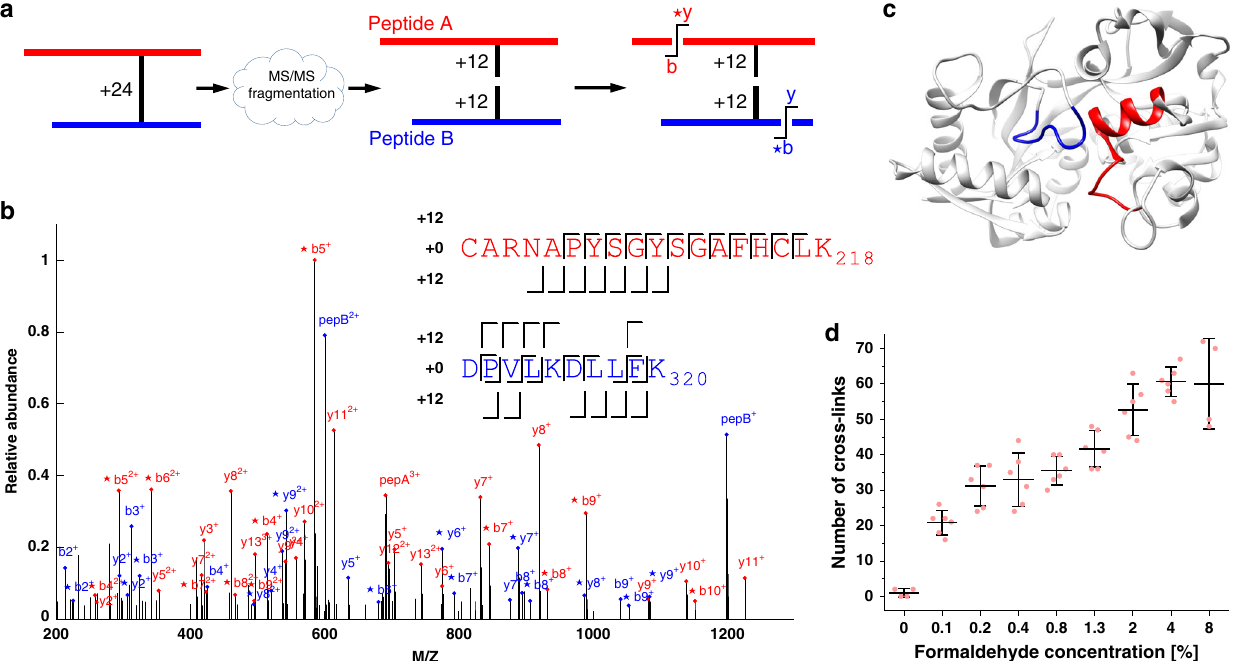
Fig. 3 Mass spectrometry characteristics of FA cross-links. a The MS/MS fragmentation of a formaldehyde cross-link breaks the ion to its two peptides, each with an additional mass of 12 Da. The two peptides then break a second time to produce b- and y-fragments. b The MS/MS spectrum of a cross-link between two peptides of ovotransferrin. pepA and pepB are peaks matching the total mass of the corresponding peptides plus 12 Da. Peaks annotated with *b or *y match the masses of the corresponding b- and y-fragments plus 12 Da. For clarity, only peaks with intensities in the top quartile are shown. The annotation of the full spectrum is shown in Supplementary Fig. 3. c The two peptides identi fi ed in the above MS/MS spectrum are spatially close to each other in the crystallographic structure of ovotransferrin (PDBid 1OVT 38 ). d The average number of cross-links identi fi ed for each formaldehyde concentration on a mixture of three proteins. Means and standard deviations calculated across three independent experiments, each with two technical replicates. The estimated false-detection rate is 3%. Source data are provided as a Source Data fi le.